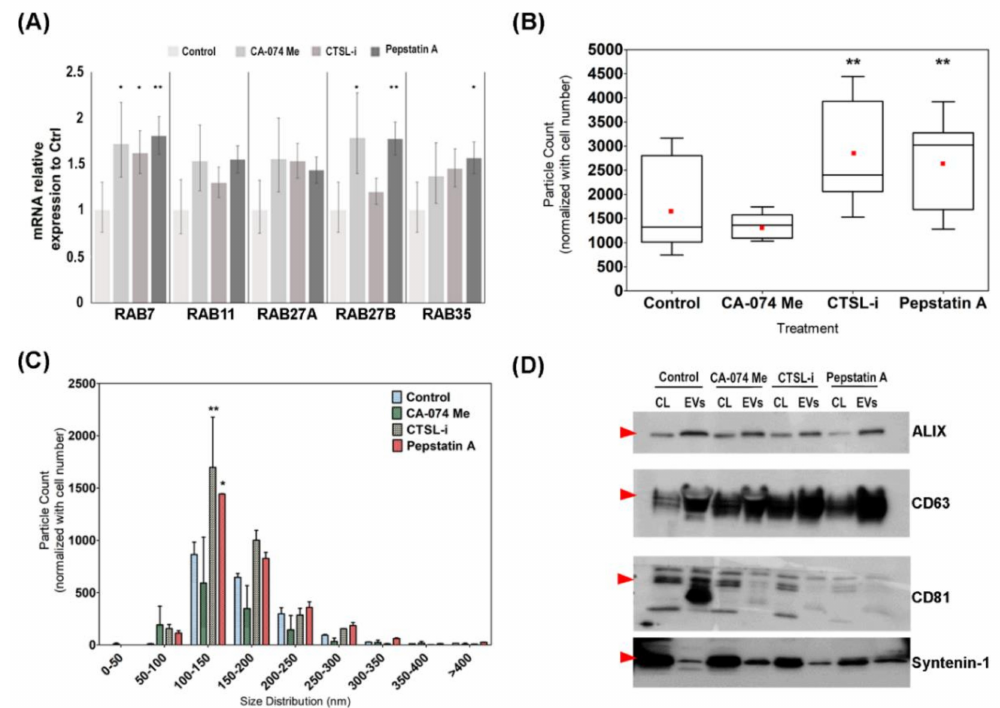
Figure 4. Chemical inhibition of cathepsin D modulate the EVs content. ( A ) Gene expression analysis of RAB GTPases after chemical inhibition of cathepsin proteolytic activities. mHypoA 2 / 28 cells were incubated in media containing 10 µ M of CTSB inhibitor (CA-074 Me), 20 µ M of CTSD inhibitor (pepstatin A (Pep-A)) or 10 µ M CTSL inhibitor II (CTSL-i) for 24 h and collected for gene expression analysis of RAB proteins. β -actin was used as the reference gene and fold change was calculated using the ∆∆ CT method. Error bars indicate S.E.M of three biological replicates (Student T-test, * p < 0.05; ** p < 0.01). ( B ) Box plots showing EVs concentration from control, CA-074 Me, CTSL-i and Pep-A treated mHypoA 2 / 28 cells as measured through nanoparticle tracking analysis (NTA). EVs were quantified by particle count that was normalized against total cell count for each condition. Red dot represents the mean particle count for each treatment. Error bars indicate S.E.M of three biological replicates (One-way ANOVA, ** p < 0.01). ( C ) Comparison of the size distribution of EVs from the various treatment, Bin size is 50 nm. Number of particles in each bin size is normalized against total cell count. Error bars indicate S.E.M of three biological replicates (Two-way ANOVA, * p < 0.05, ** p < 0.01). ( D ) Western blot analysis of known EVs marker ALIX, CD63, CD81 and syntenin-1 following 24 h of chemical inhibition against CTSB, CTSD, and CTSL in mHypoA2 / 28 cells. (CL: Cell lysate; EVs: Extracellular Vesicles; Red arrow indicate the band of